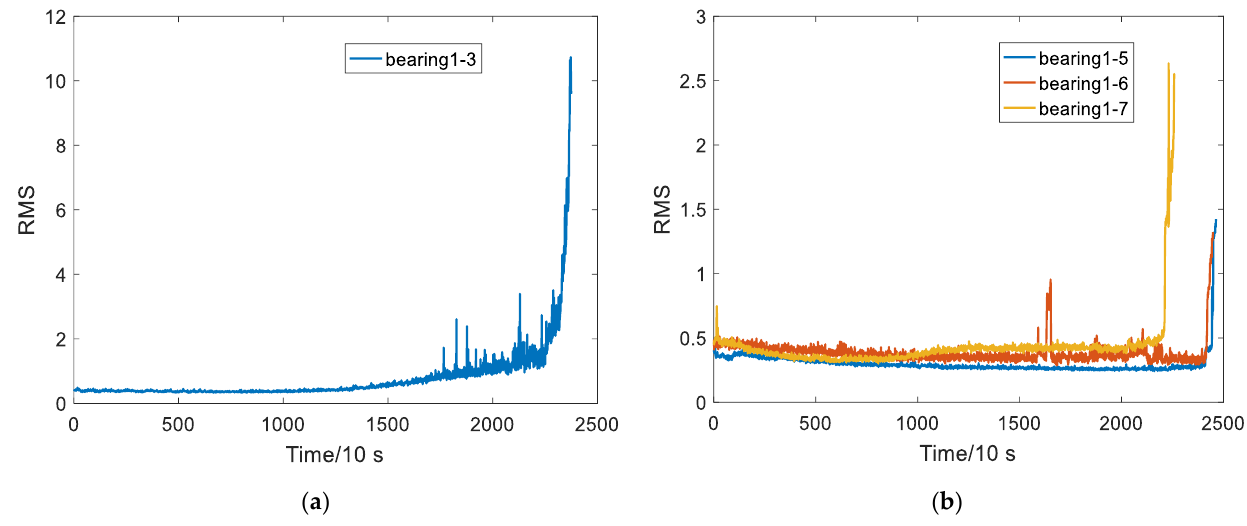
Figure 14. Comparison of RMSE metrics for each bearing. ( a ) RMS index of bearing 1 – 3; ( b ) RMS index of bearings 1 – 5, 1 – 6, and 1 – 7.